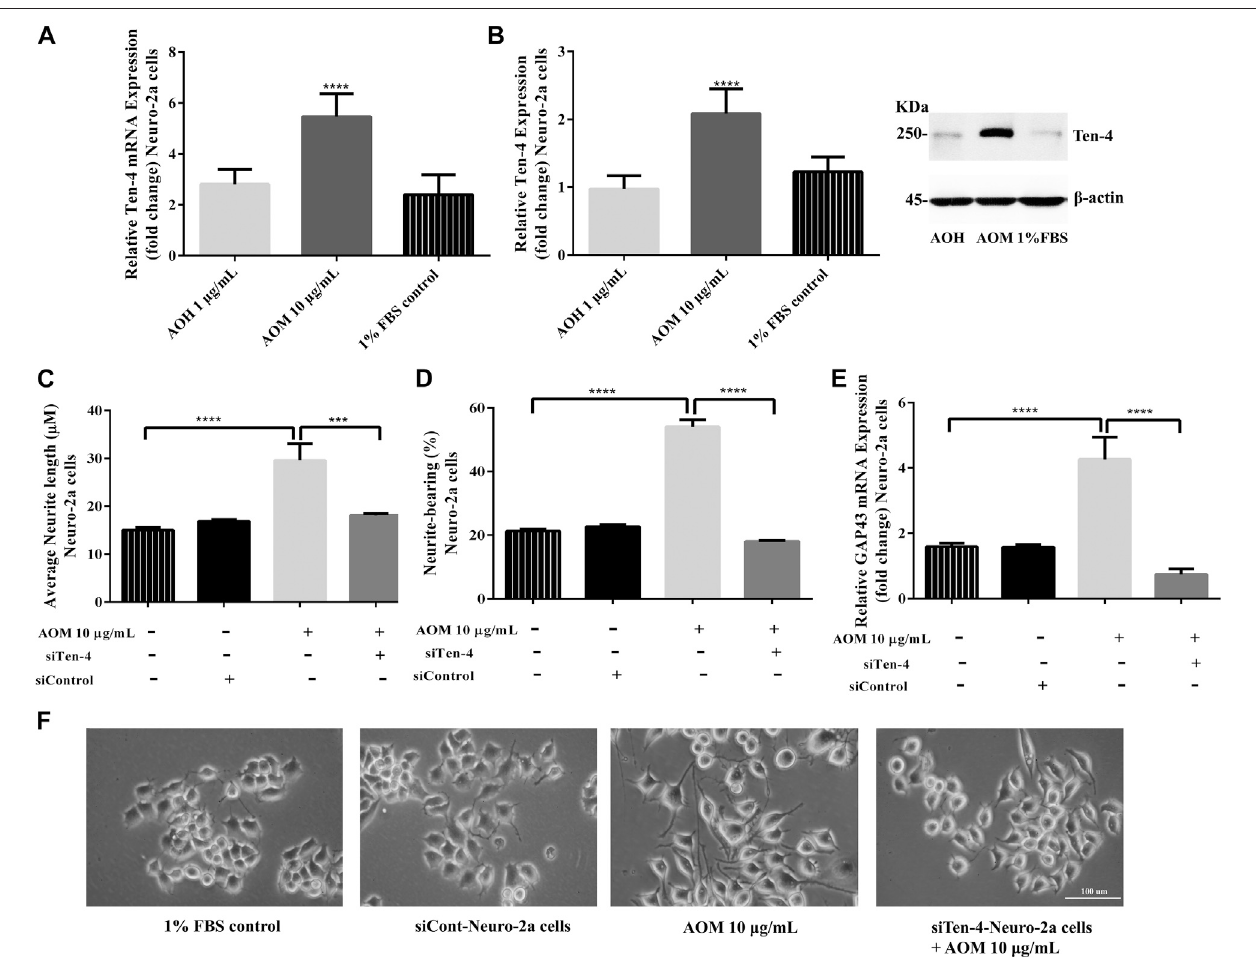
FIGURE8| Effect ofAOextractsonTen-4-mediated neuriteoutgrowth.AOmethanolextracttreatment increasedexpressionlevel ofTen-4mRNA (A) and protein (B) . AO methanol extract failed to induced neurite length (C) and neurite-bearing cells (D) in siTen-4-Neuro-2a cells. Results were con fi rmed by GAP43 mRNA expression (E) . Cell morphology of Neuro-2a cells was observed under a microscope at 10 × magni fi cation (F) . Samples were treated with AO extracts for 48 h. Whole- cell lysates were subjected to western blot analysis at the Ten-4 level after AO extract treatment. β -actin was used as endogenous loading control for western blot assay and internal control for RT-PCR assay. All data were normalized to 10% FBS control levels in siCont-Neuro-2a cells and the results are expressed as the means ± SEM of independent experiments ( n (cid:1) 3). * p < 0.05, ** p < 0.01, *** p < 0.001 and **** p < 0.0001 compared to the 1% FBS control.